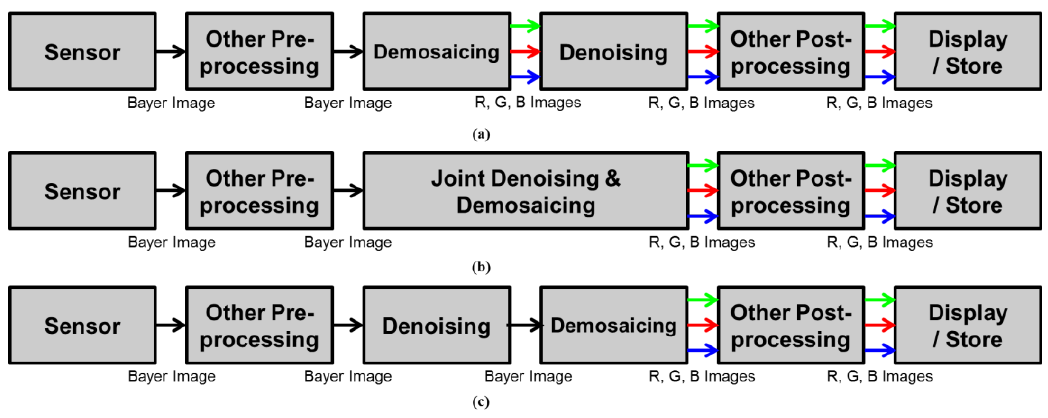
Figure 1. Image Processing Pipelines; ( a ) demosaicing, and then denoising; ( b ) joint denoising and demosaicing; ( c ) the proposed framework (denoising, and then demosaicing).